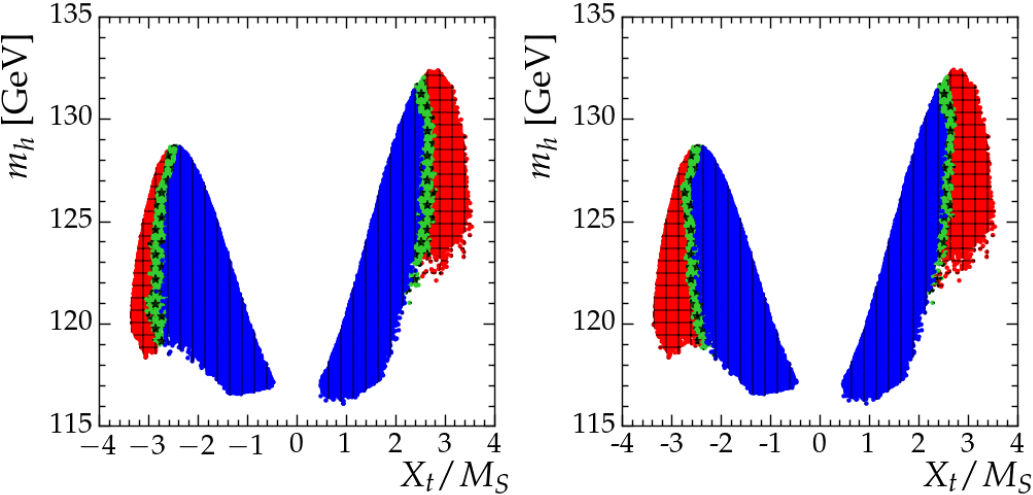
Figure 1 . Stable (blue, vertical lines), meta-stable (green, stars) and unstable (red, checkered) vacuum in the m h vs. X t =M S plane. The left panel represents three (cid:12)eld analysis and the right panel four (cid:12)eld analysis.